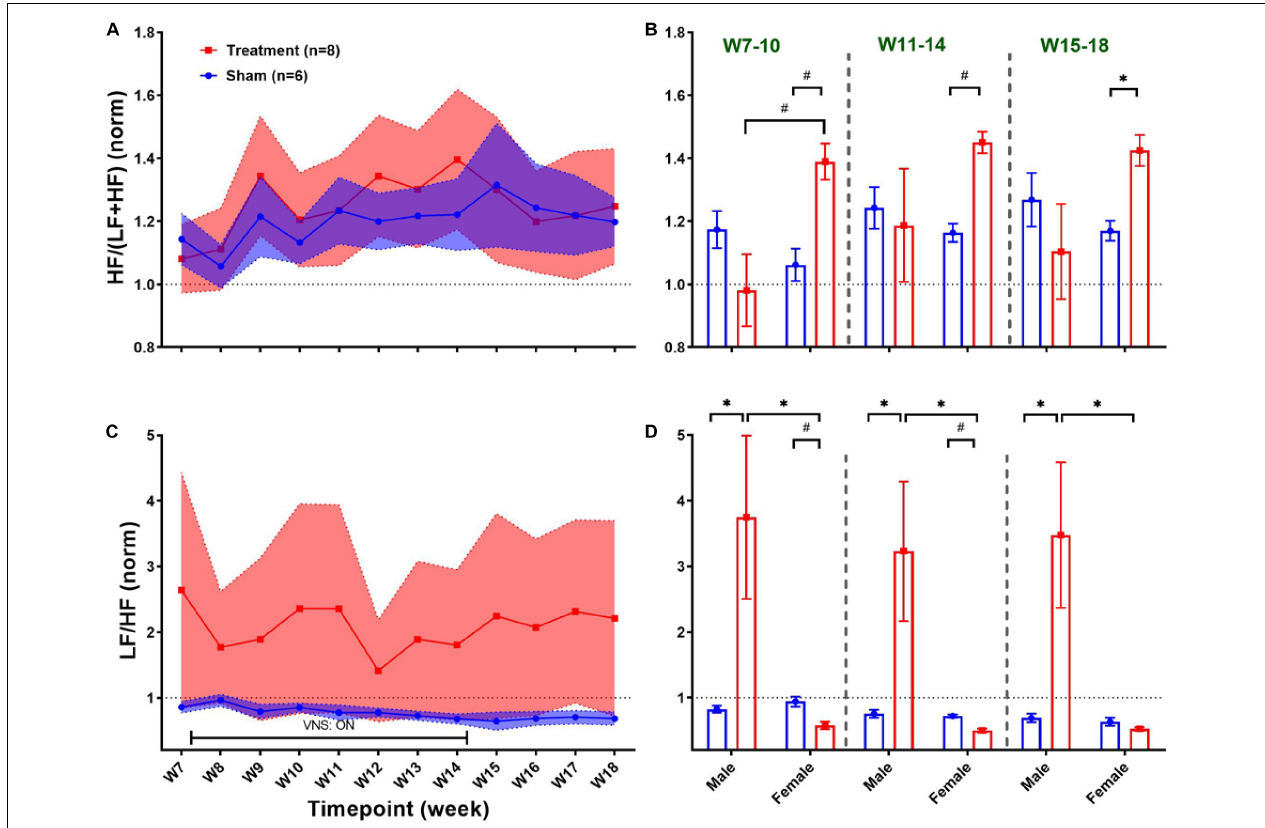
FIGURE 6 | Normalized long-term trends for HRV frequency-domain features (mean ± SEM). (A,B) The long-term effect of VNS on HF/(LF + HF) is not significantly different between the Treatment and Sham groups. However, when male and female rats were compared from each group, a significant increase in HF/(LF + HF) was observed in female rats by VNS, during VNS_Early , VNS_Late , and Recovery phases. (C,D) There is no significant difference between the Treatment and Sham groups in long-term effect of VNS on LF/HF. However, when male and female rats were compared from each group, a significant increase in male and reduction in female rats was observed by VNS during all three shown phases. * p < 0.05 and # p <